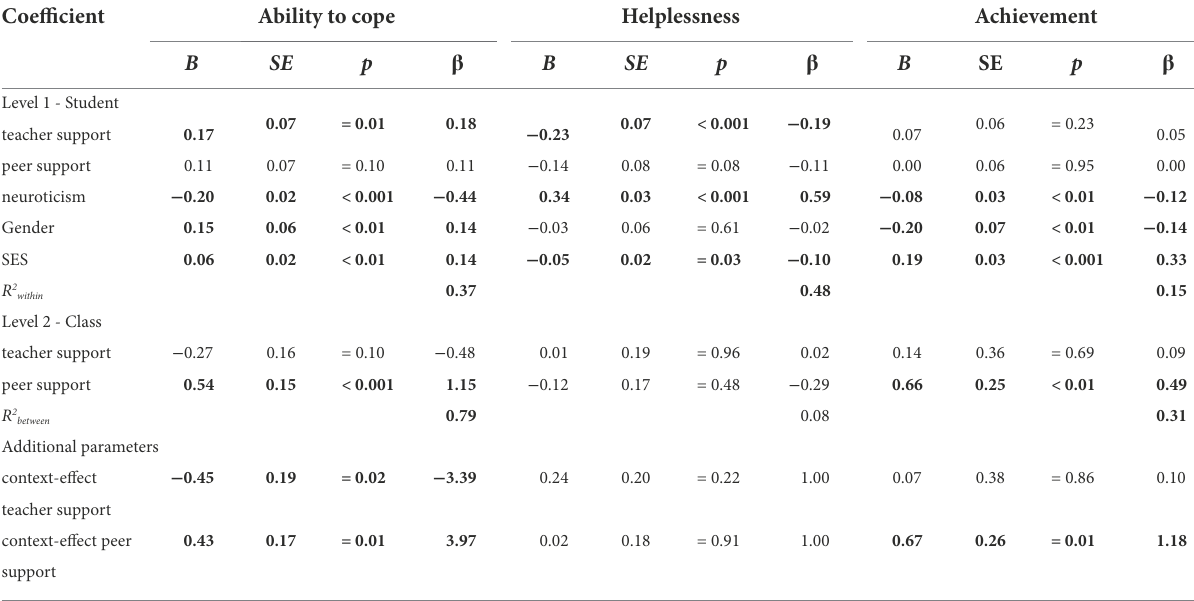
TABLE 4 Results of multilevel structural equation